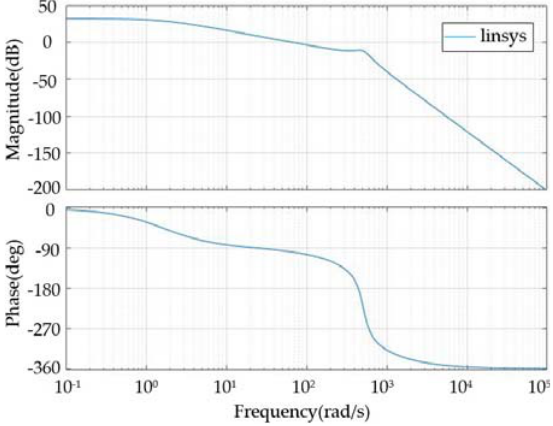
Figure 13. The ITAE box plot.